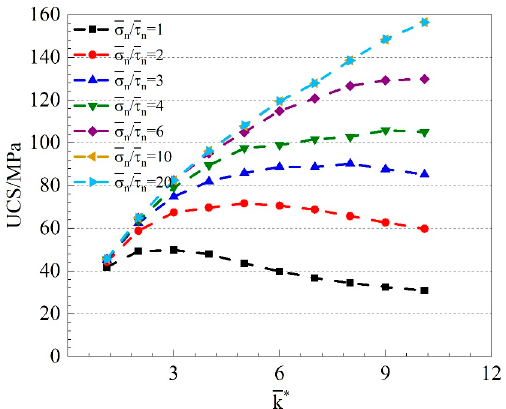
Figure 16. Relationship between bond normal-to-shear stress ratio ( σ n / τ n ) and uniaxial compressive strength (UCS).